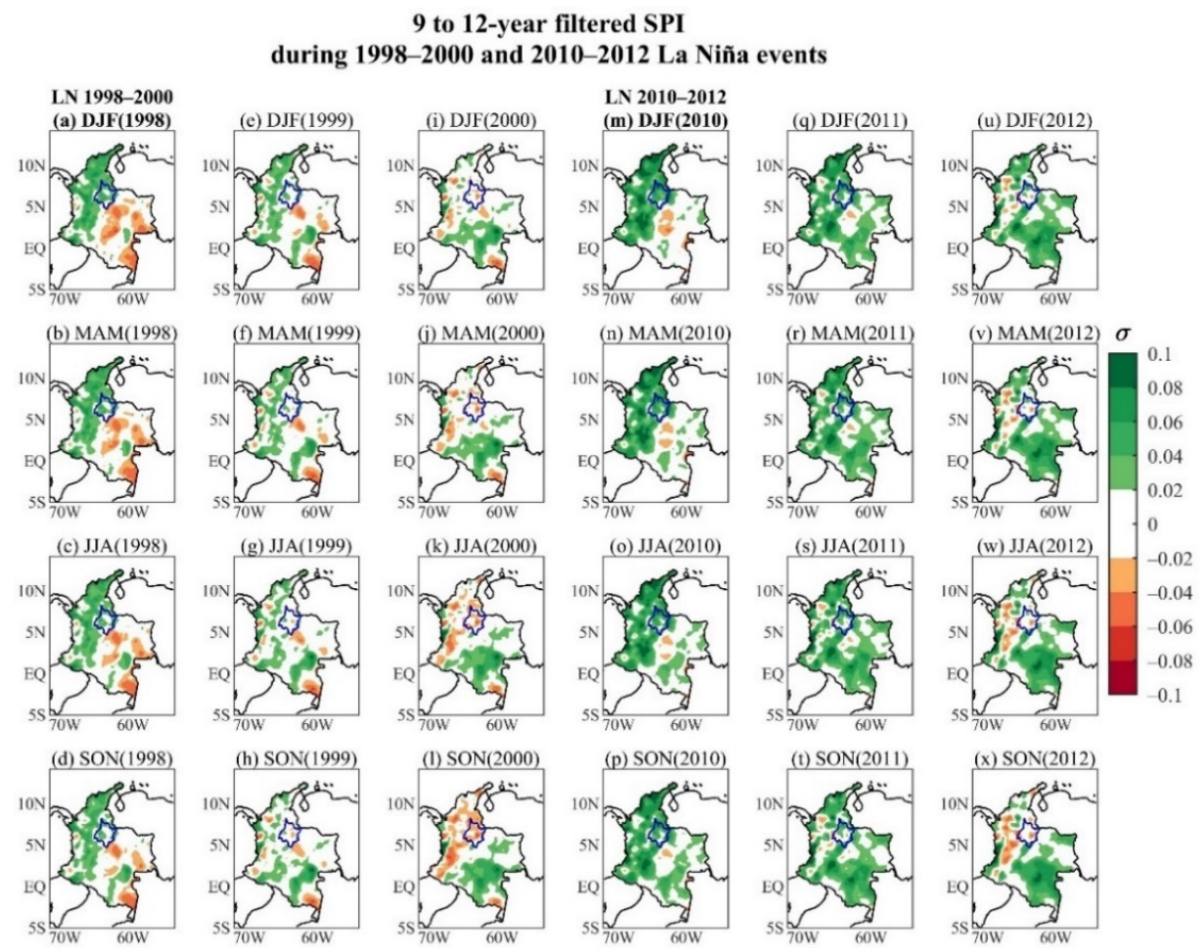
Figure 14. Seasonal standardized precipitation index (SPI) filtered at quasi ‐ decadal 9–12 ‐ year scales